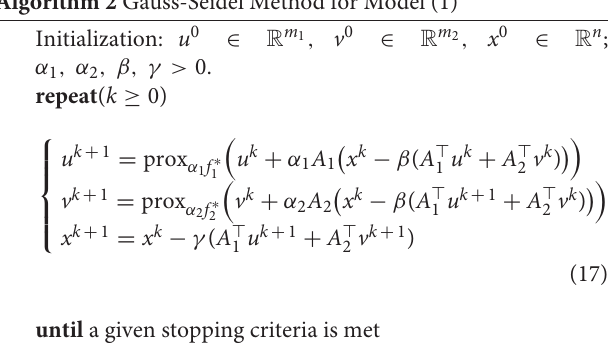
Algorithm 2 Gauss-Seidel Method for Model